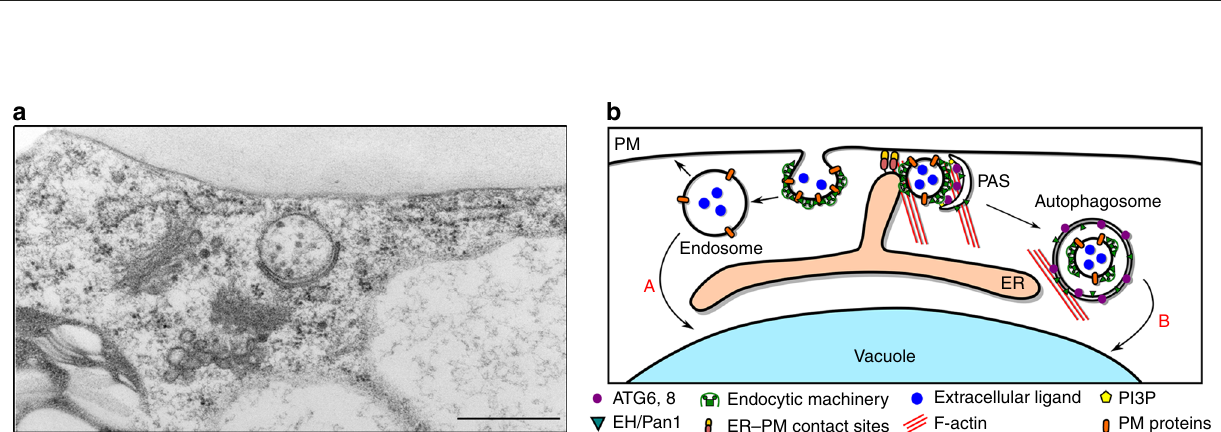
Fig. 6 Altered expression of VAP27-1 and AtEH1/Pan1 affects autophagic activity. a RT-qPCR of selected autophagy-related genes in N. benthamiana leaves transiently expressing either GFP-AtEH1/Pan1 or empty vectors (control). In agreement with the increase in the number of autophagosomes upon AtEH1/ Pan1 overexpression, the transcription of most ATG genes is upregulated in the cells transiently transfected with AtEH1/Pan1. The difference between two experiments was calculated by Student ’ s T -test, and the signi fi cance is indicated with a single (p ≤ 0.05) or double ( P ≤ 0.01) asterisk. b , c Confocal images of root meristems ( b ) and root differentiation/maturation zone cells ( c ) of seedlings taken at the respective time points after transfer to β -Estradiol- containing medium. At 12 h post induction, clear cytoplasmic signal of AtEH1/Pan1 can be detected and the fi rst autophagosomes appear in the differentiation/maturation zone. At 24 h post induction, the signal in the meristem cells is predominantly membrane-associated and autophagosomes in the differentiation/maturation zone are clearly present. At 48 – 72 h post induction, the signal in the meristem zone decreases, while autophagosomes remain very apparent in the differentiation/maturation zone (Scale bars: 15 μ m). d After induction by transfer, AtEH1/Pan1 is detected after 12 h and increases up to 48 h. ATG8 protein levels also increase up to 48 h. ATG8 levels of transferred seedlings to non-induced and induced conditions are plotted and show a clear rise from 48 h onward, co-occurring with a decrease in AtEH1/Pan1 abundance. The plot shows the average of two biological repeats. Ponceau S staining was used as loading control. e Arabidopsis plants expressing pUBQ10::mCherry-ATG8e and AtEH1/Pan1-GFP, driven by the β -Estradiol inducible promoter. After induction, strong co-localization between the two proteins was found (Scale bars: 10 μ m). f Absence of co-localization between induced AtEH1/Pan1-GFP punctae and the protein aggregation dye ProteoStat ® shows that the AtEH1/Pan1-positive punctae are not aggresomes (Scale bars: 10 μ m). g Silencing of AtEH1/Pan1 expression in Arabidopsis (two independent AtEH1/Pan1 RNAi lines, both of which with about 30% reduction in gene expression) signi fi cantly reduced the number of autophagosomes (visualized and measured by the amount of ATG8 positive punctae from an area of 20 × 50 μ m, n = 10) upon nitrogen starvation, indicating that reduction of AtEH1/Pan1 affects autophagy activity (Scale bars: 10 μ m). h . AtEH1/Pan1 RNAi plants exhibit retarded root growth (7.8 ± 1.1 mm and 8.0 ± 1.2 mm, respectively) in nutrient depleted medium (MS -N) compared to the wild type (10.1 ±